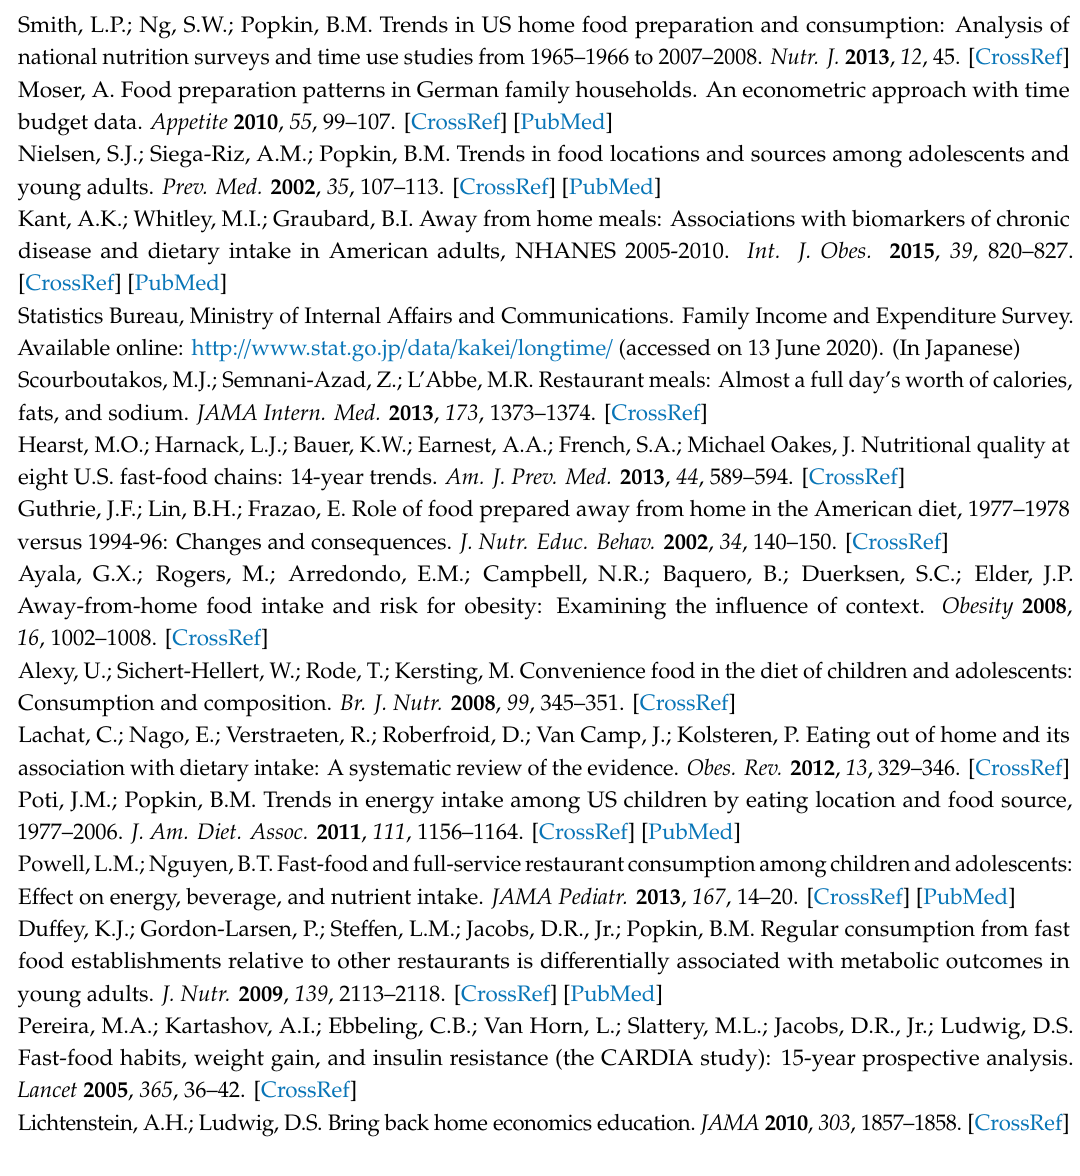
s1, Table S1: Mediation analyses between low frequency of home cooking and adolescents’ indicators of cardiometabolic factors among Japanese junior high school